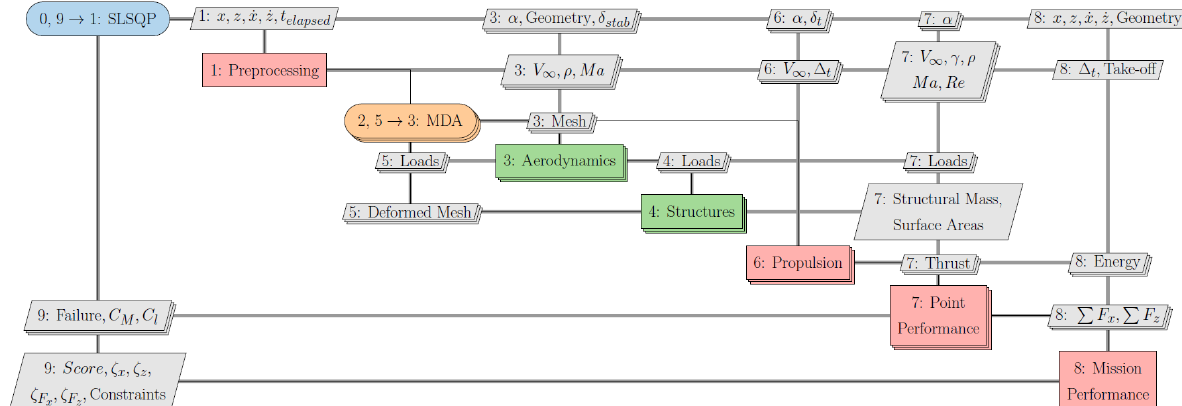
Figure 17. Concurrent design framework XDSM diagram.